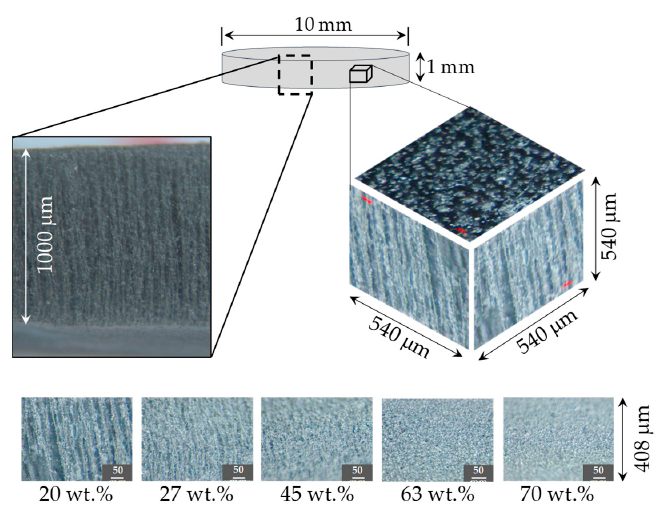
Figure 7. Microphotographs of rheological material samples reinforced with carbonyl iron microparticles. Particle alignment was observed in the material samples for 20, 27 and 45 wt % of CIPs concentrations. However, for specimens with 63 and 70 wt % of CIPs, no particle patterns were observed after exposing the material samples to magnetic flux densities during the composite material manufacturing process.